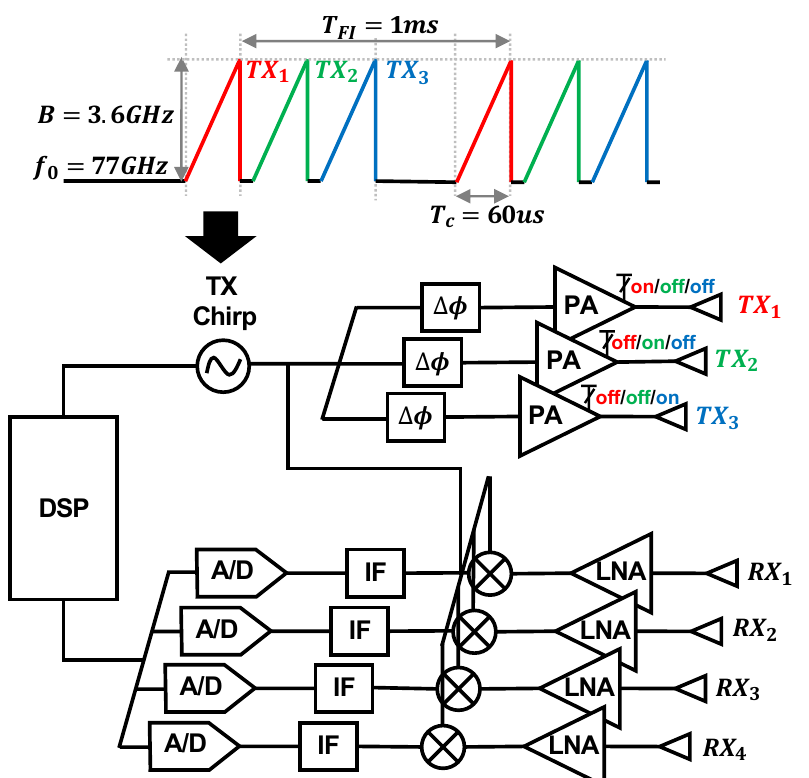
Figure 5. Block diagram of the Texas Instruments AWR6843 Radio Frequency (RF) array and the transmit waveform used in our study. The three transmit channels are colored. The signal is transmitted via TDM, meaning only one channel is transmitting at a given time, while the other channels are switched off. The four receive antennas are also